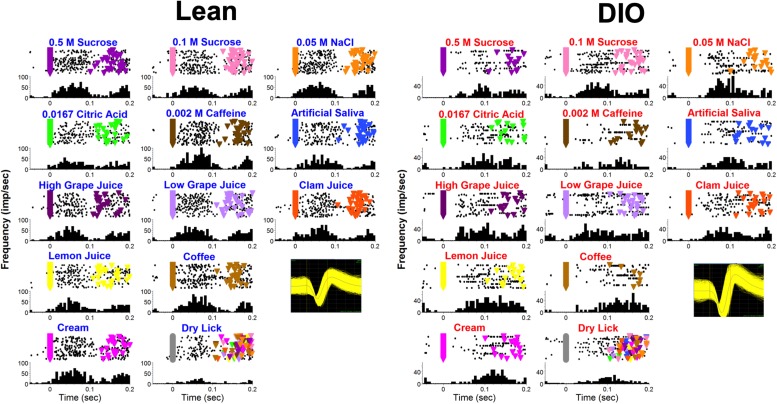
Examples of lick-by-lick taste responses in one unit from a lean rat (left) and another from a DIO rat (right). Top of each panel shows a raster; bottom of each panel shows a PSTH. Colored triangles indicate reinforced licks. Inset shows waveforms.